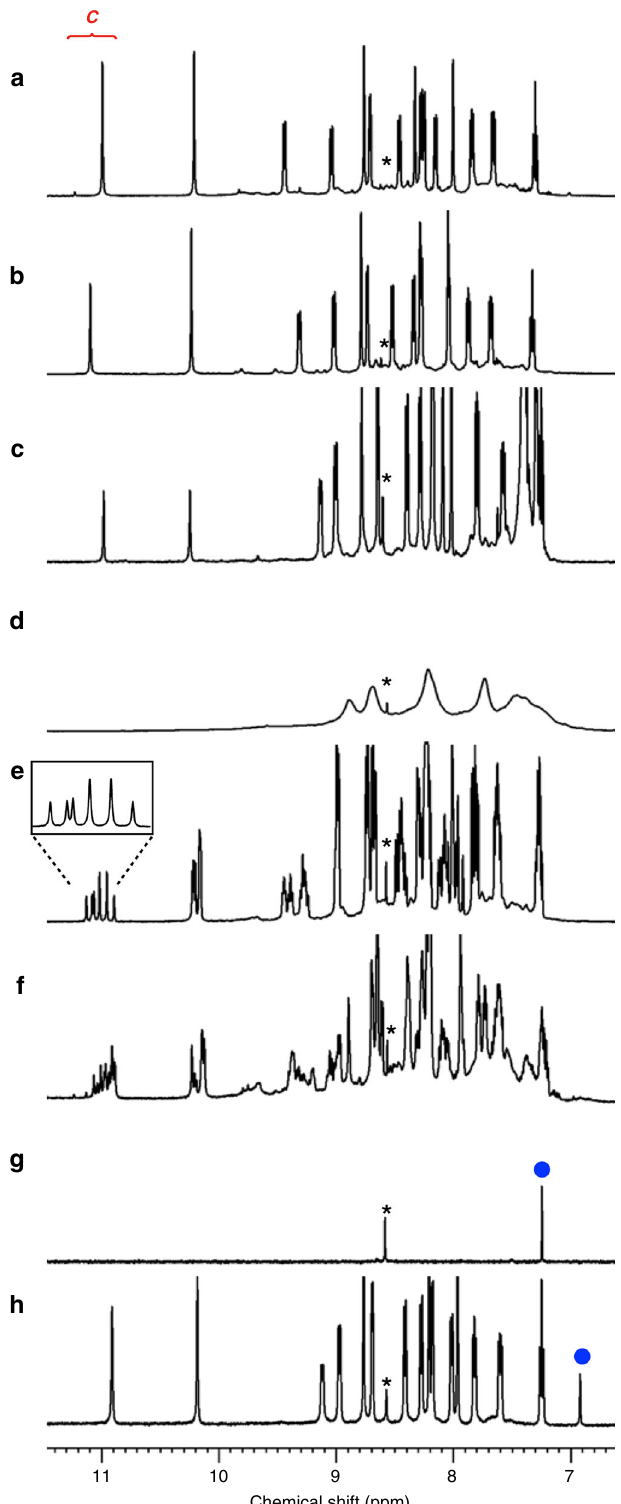
Fig. 7 1 H NMR spectra after complexation of peptide ligands with various residues at the Z position and Ag + . (aromatic region, CD 3 NO 2 , 500 MHz, 300 K) a [6]catenane 6 , and the mixture after complexation of b 5L + Ag + , c 5K + Ag + , d 5G + Ag + , e 5 + 5L + Ag + (1:1:2), and f 5 + 7 + Ag + (3:1:4). g G only, and h the encapsulation complex after complexation of 9 + Ag + + G (1:1:0.04). Signals with blue circles indicate the aromatic proton signal of G . Signals with asterisks derive from the